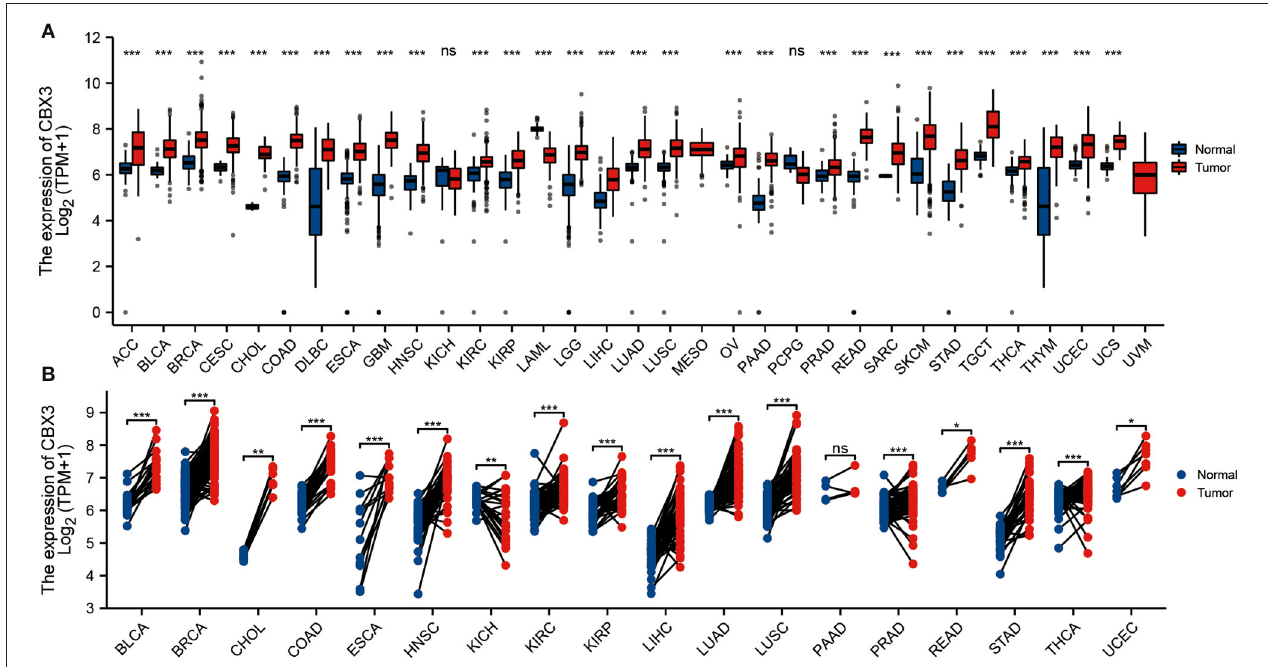
FIGURE 1 | Expression of CBX3. (A) Contrast of the expression of CBX3 between tumor samples and non-tumor normal specimens. (B) Contrast of CBX3 expression between tumor specimens and paired non-tumor normal specimens. * P < 0.05, ** P < 0.01, *** P < 0.001.